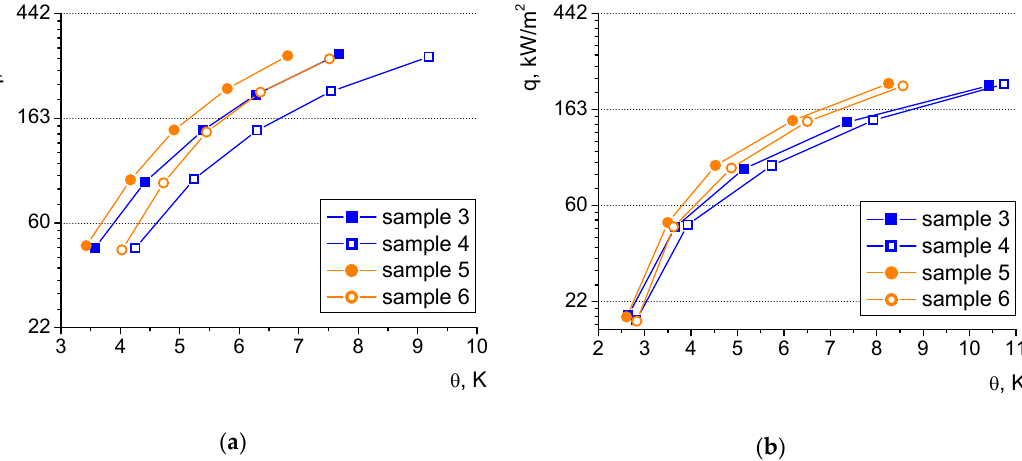
Figure 8. Heat flux vs. wall superheat for samples of comparable heat transfer areas; ( a ) distilled water, ( b ) ethyl alcohol.